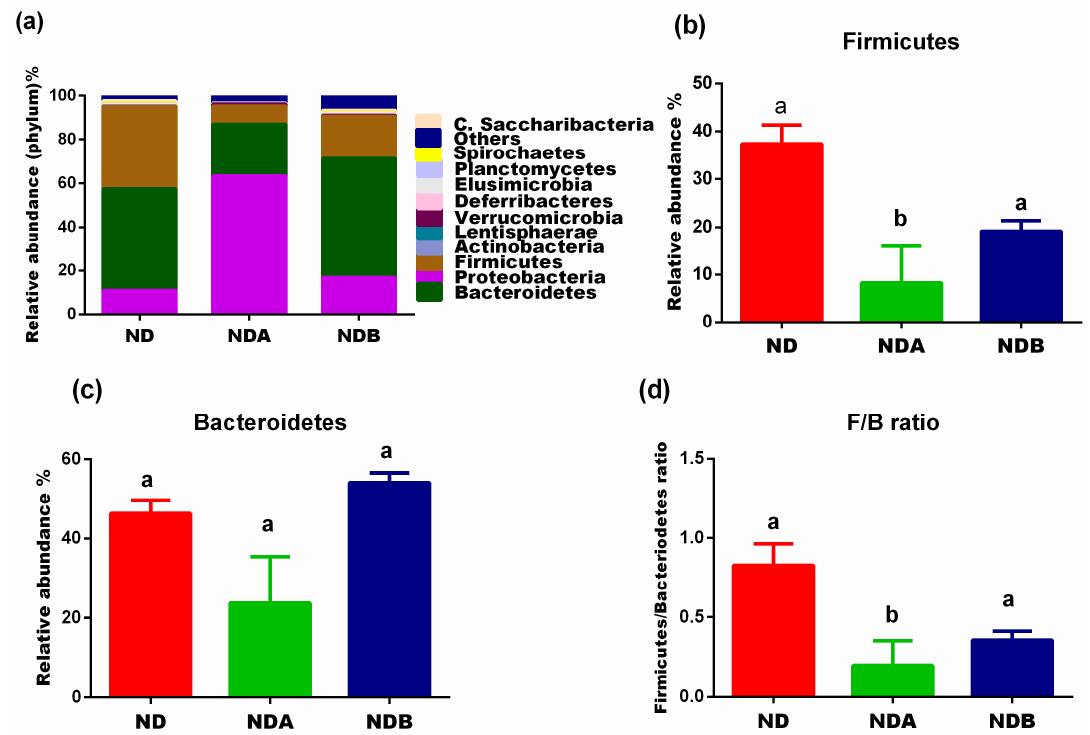
Nutrients 2021 , 13 , x FOR PEER REVIEW Figure 3. Effects of urolithins on the composition of the gut microbiota at the phylum level. Relative abundance at the phylum level ( a ), relative levels of the Firmicutes ( b ), relative levels of the Bacteriodetes ( c ), Firmicutes/Bacteriodetes ratio ( d ). a,b Data are expressed as mean ± SE. Mean values bearing different letters are significantly different ( p < 0.05).